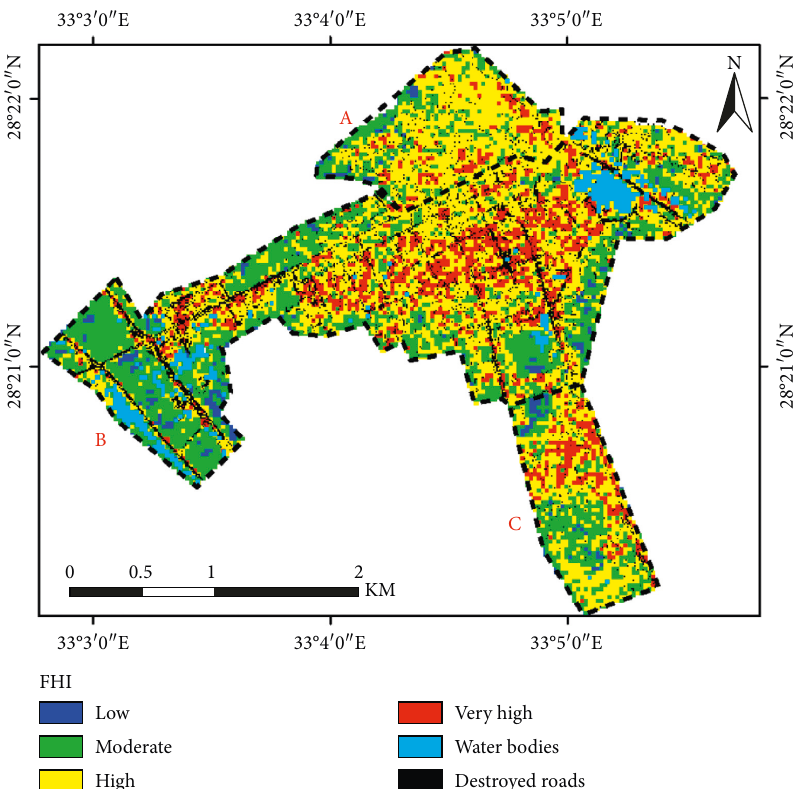
Figure 13: The coincidence of the destroyed roads and the water bodies with the very high and high hazard.